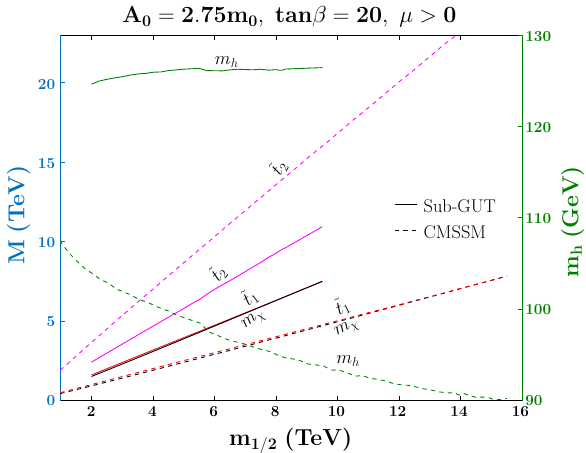
Fig. 7 The masses of the neutralino LSP, the left and right stop, and the SM like Higgs boson in the CMSSM and sub-GUT with M in = 10 9 GeV for A 0 = 2 . 75 m 0 , tan β = 20 and sgn (μ) > 0